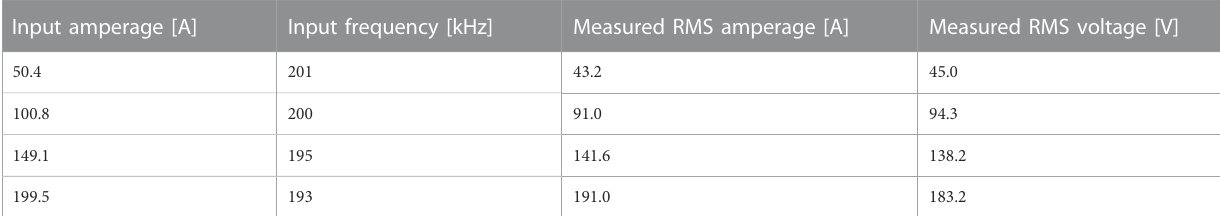
TABLE 3 RMS values of applied amperage and frequencies as